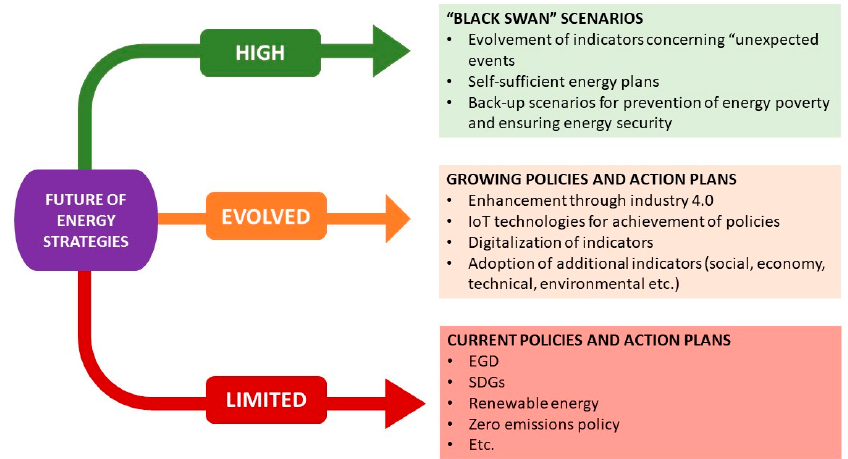
Figure 2. The gap of existing and evolving policies and action plans regarding energy in accordance with the “black swan” scenarios of unexpected events.